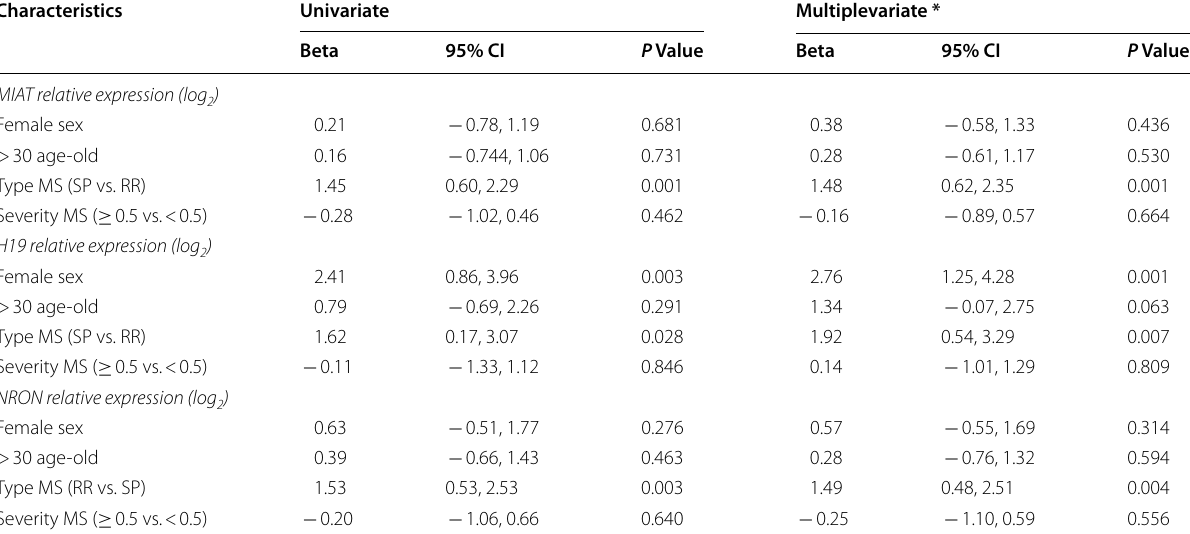
Table 3 Association between MIAT, H19, and NRON levels with clinical parameters in MS patients: using univariate and multiple linear regression models